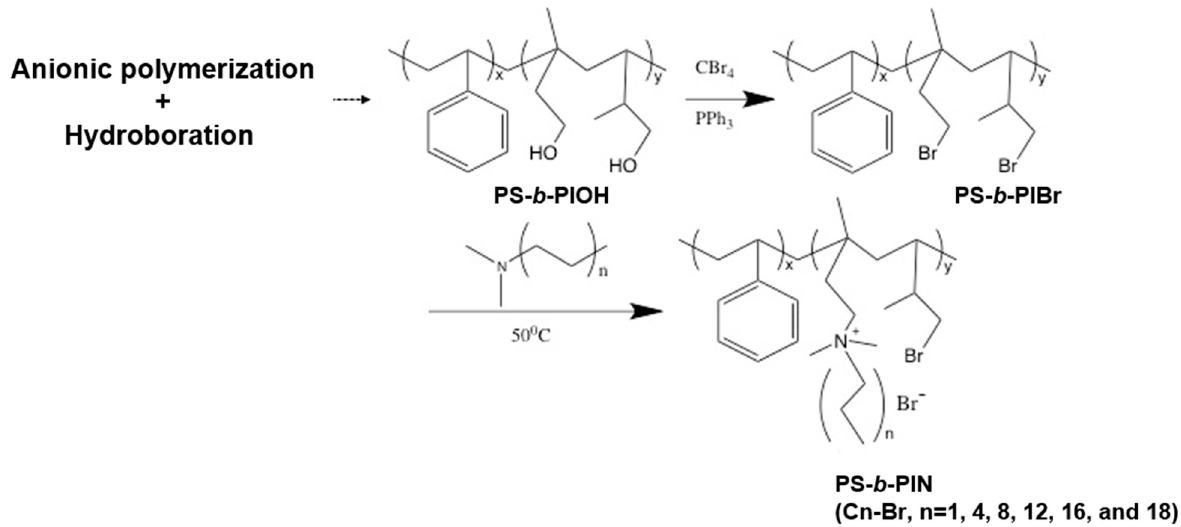
Figure 1. Synthesis of PS- b -PIN block copolymers with different side chain length.